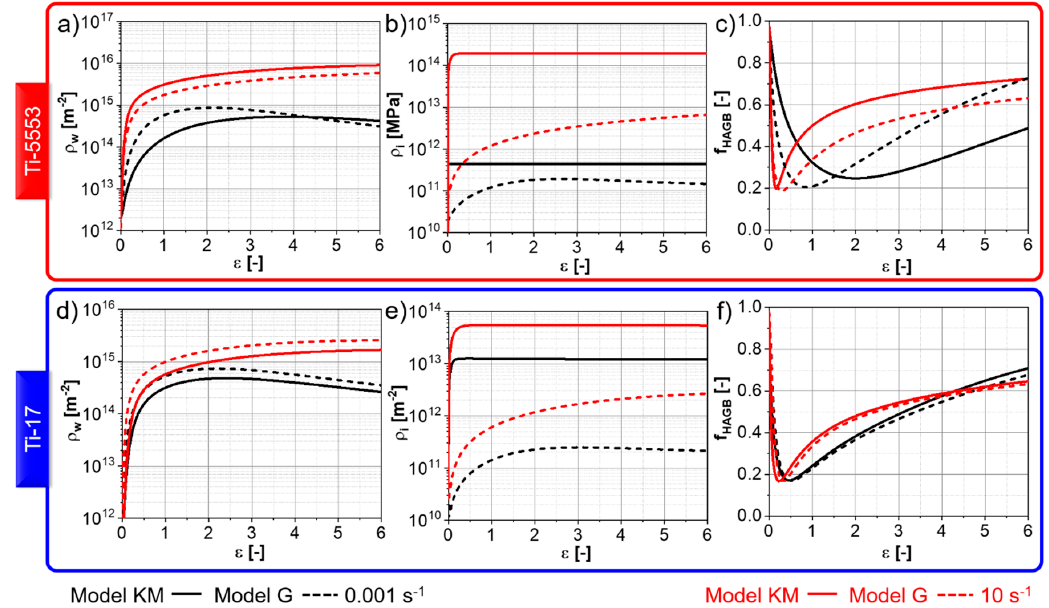
Figure 10. Simulated evolutions of ( a , d ) immobile dislocation density; ( b , e ) wall dislocation density; ( c , f ) fraction of HAGBs for the ( a – c ) Ti-5553 deformed at 920 °C and ( d – f ) Ti-17 deformed at 970 °C.